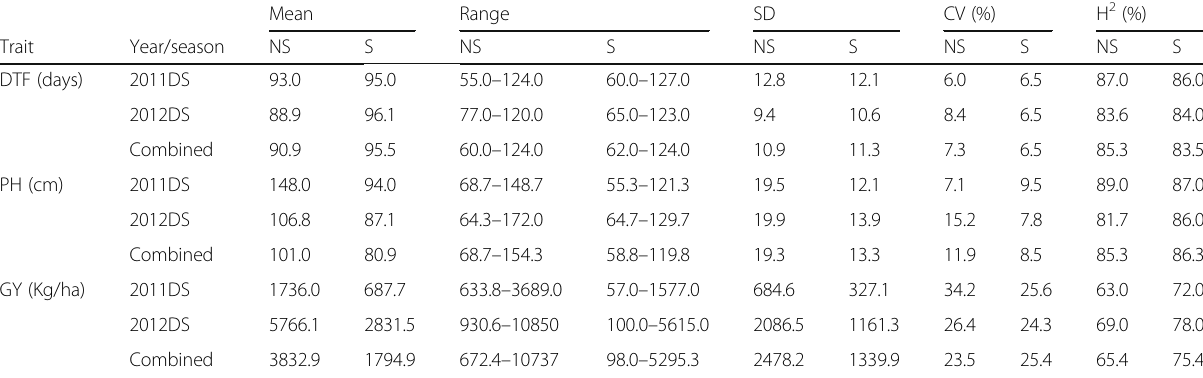
Table 1 Various statistical parameters for yield and yield-related traits under non-stress and drought stress